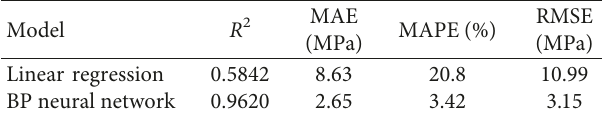
Figure 8: Fitting curve of outputs and targets of the linear model. Table 6: Prediction performance comparison between LR and